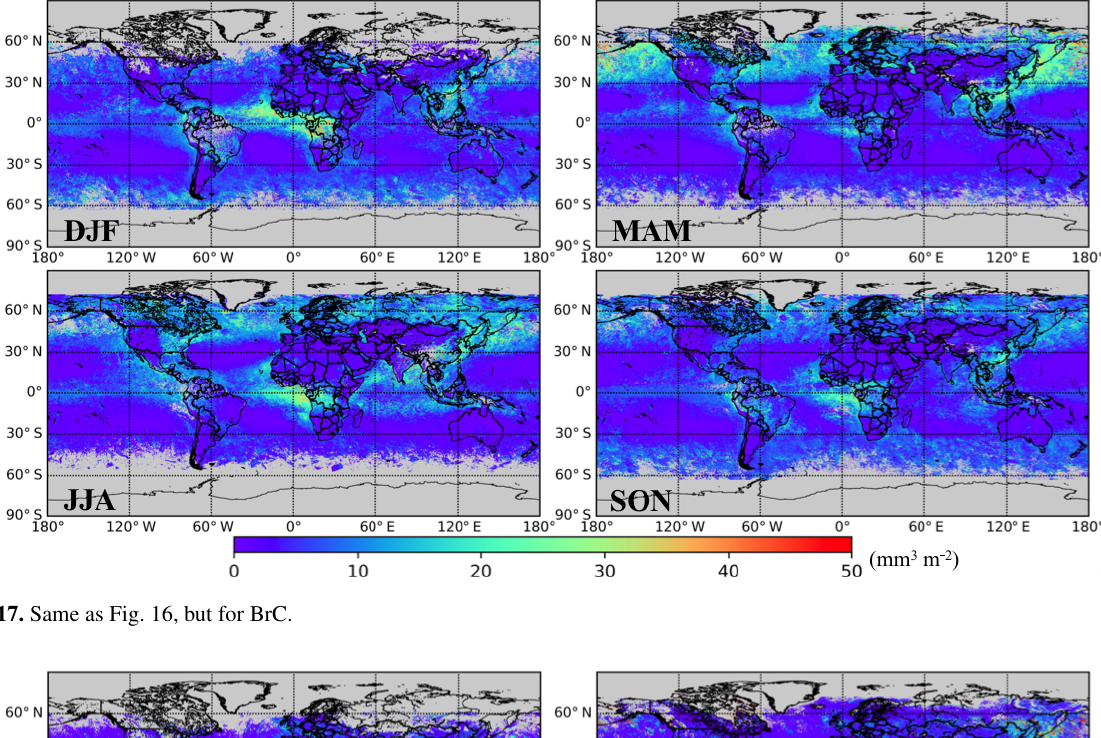
Figure 17. Same as Fig. 16, but for BrC.